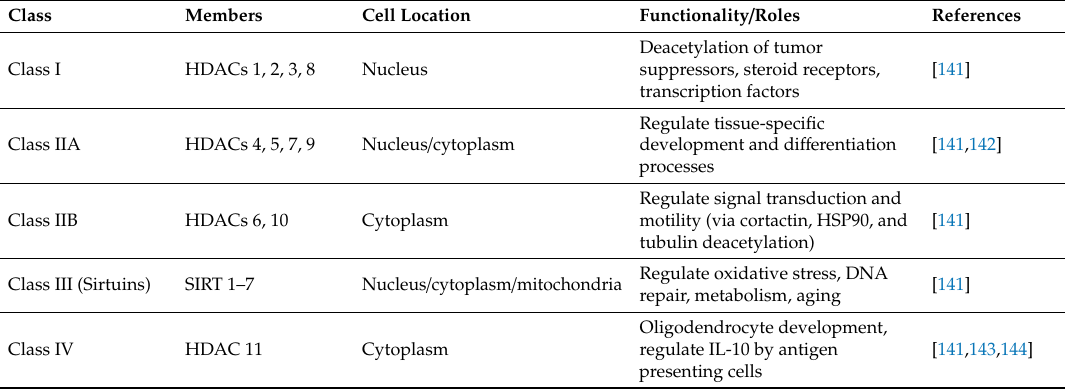
Table 1. Summary of Histone deacetylases (HDAC) classes, distribution and general